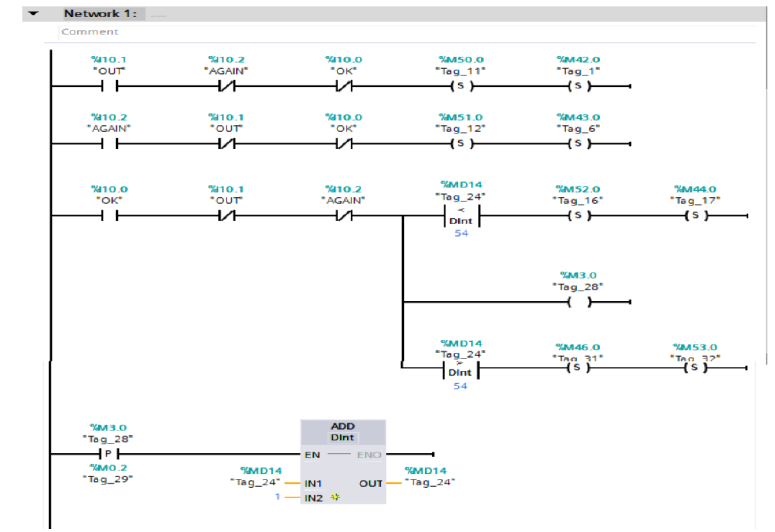
Figure 4. The flowchart and symbol used in the designed PLC and virtual system.